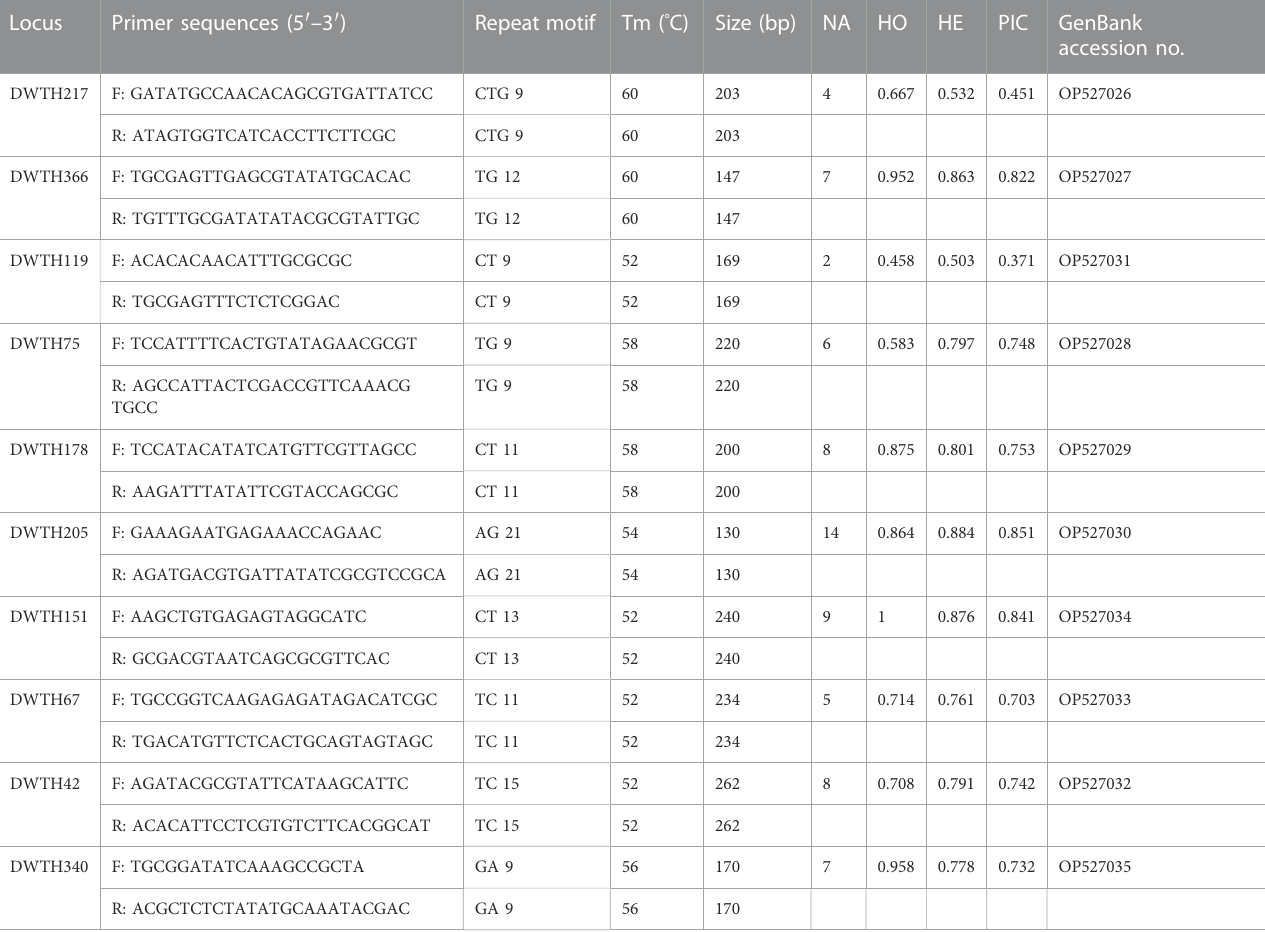
TABLE 3 10 genetic markers isolated from thelytokous D. wani . The parameters are as follows: Number of alleles (NA), observed (HO) and expected (HE) heterozygosities, and the polymorphism information content (PIC). Locus Primer sequences (5 ′ – 3 ′ )